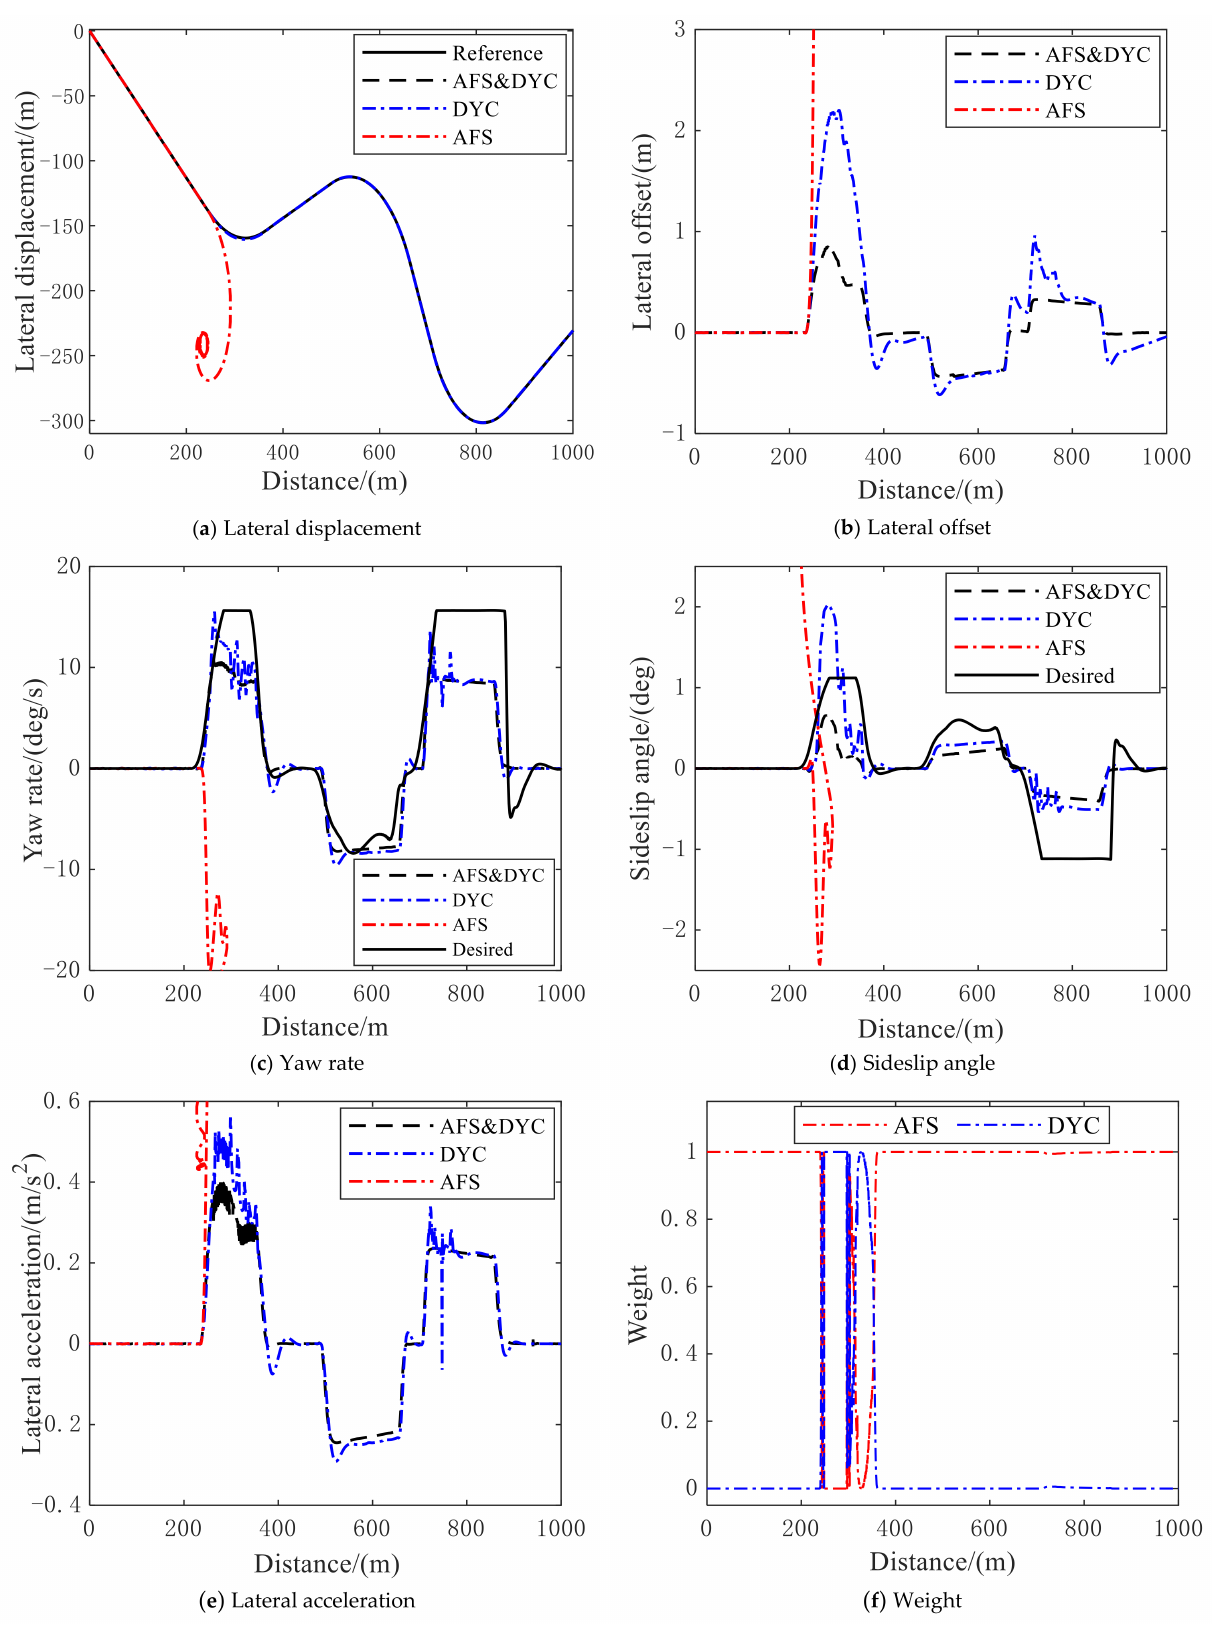
Figure 12. Performance under high speed: ( a ) lateral displacement; ( b ) lateral offset; ( c ) yaw rate; ( d ) sideslip angle; ( e ) lateral acceleration; ( f ) weight of AFS and